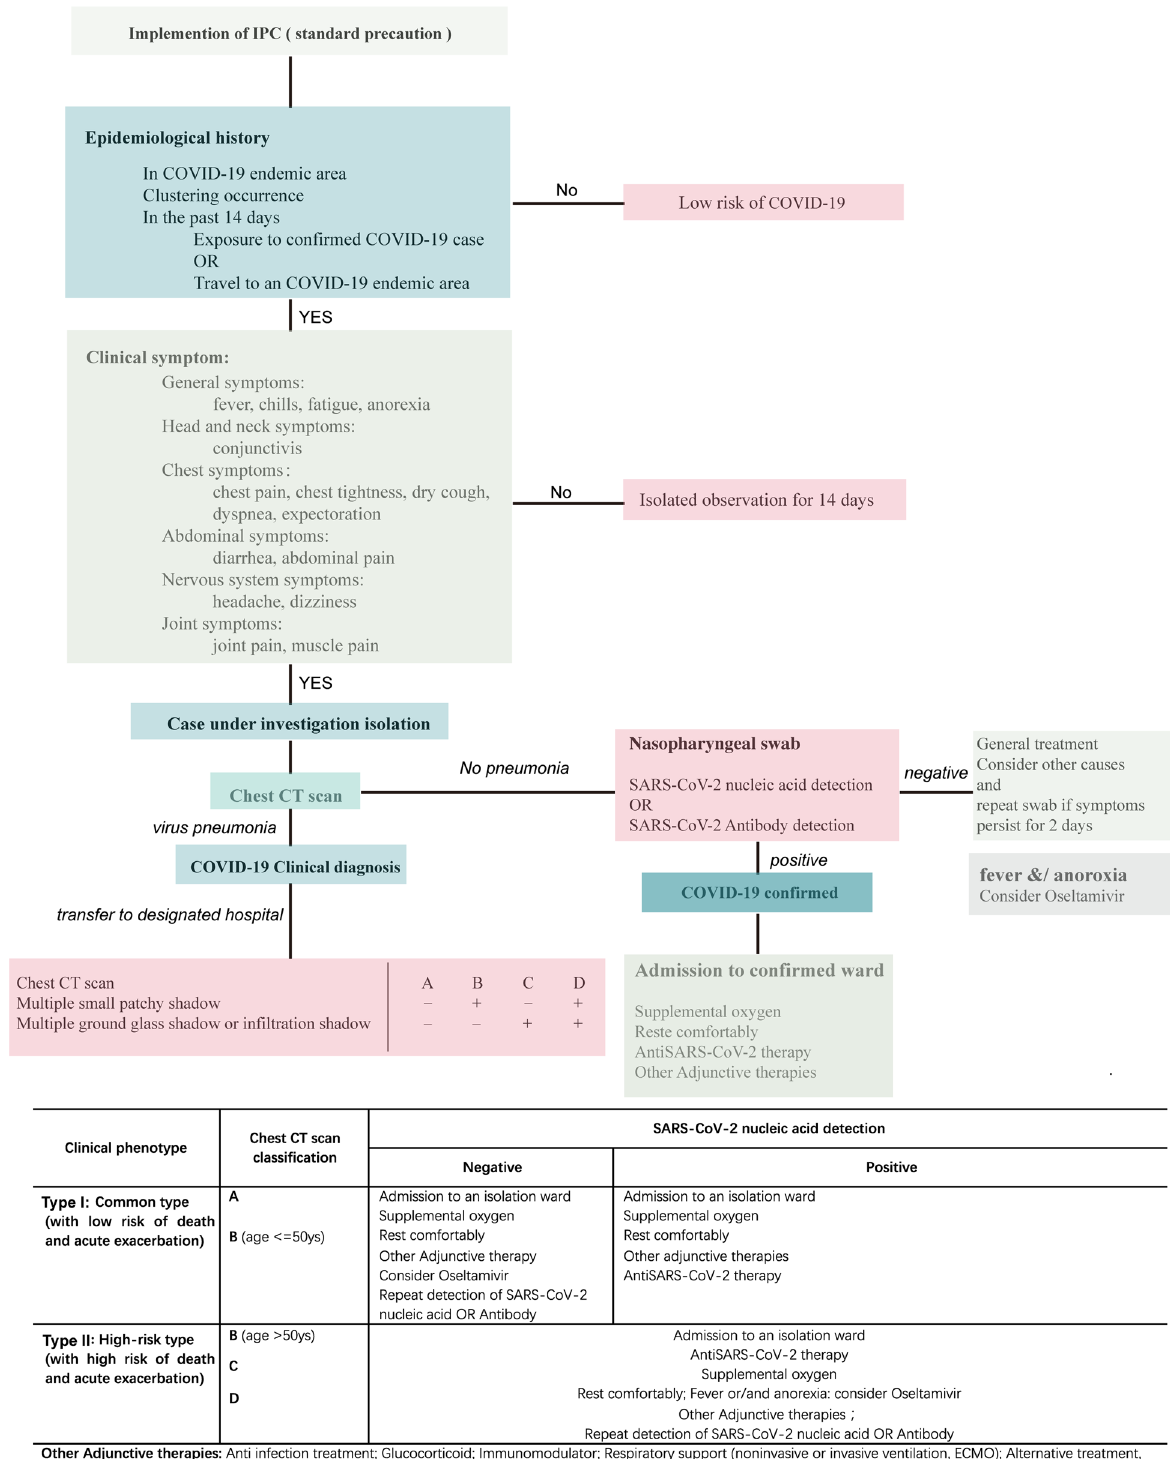
Figure 4. Proposed flow chart for treatment of COVID-19 patients in areas with limited medical